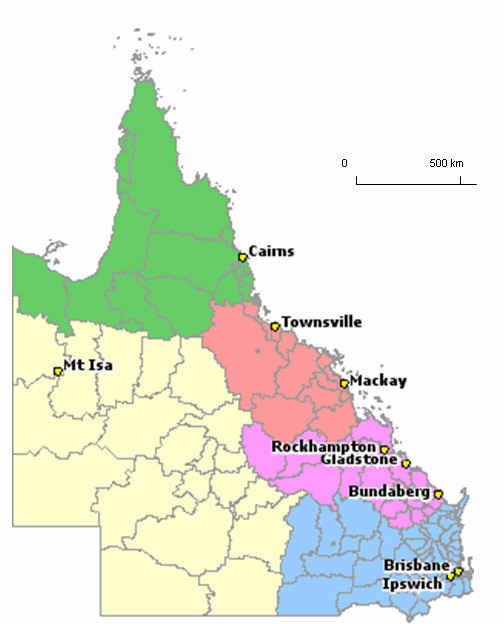
Map of Queensland.